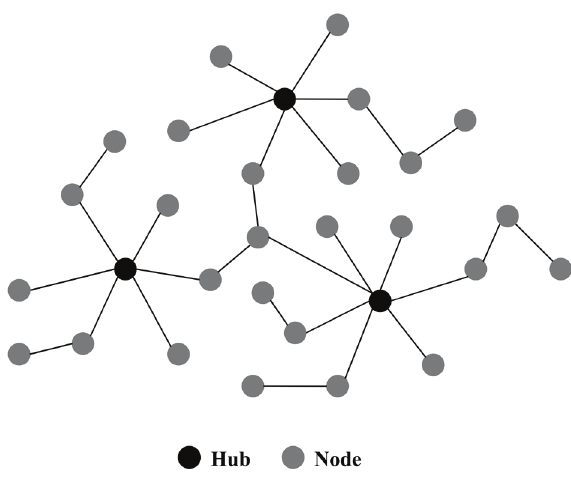
Fig. 1. A typical scale-free